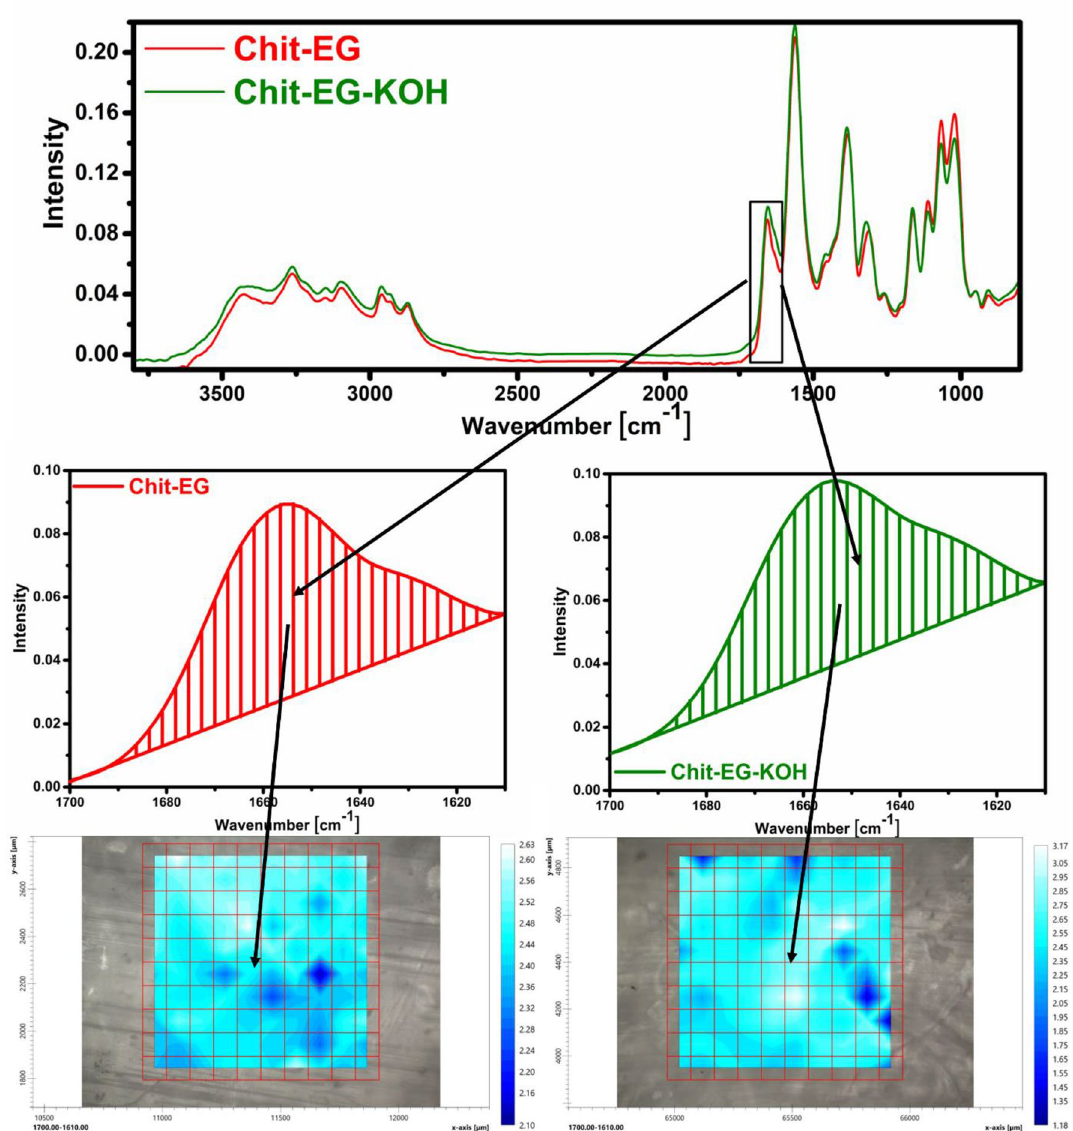
Figure 10. FTIR microscopic analysis of the Chit-EG membrane as prepared (red) and after ageing for 5 days in 6 M KOH